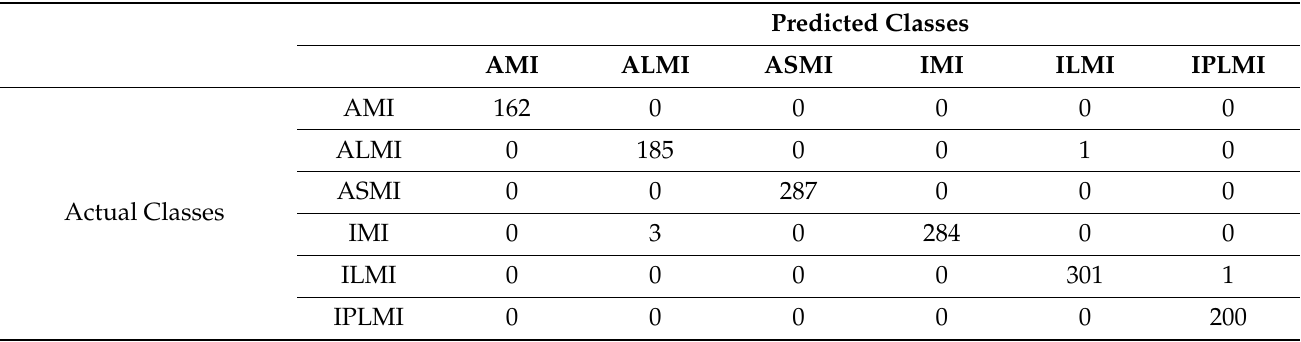
Figure 6. Plots of accuracy vs. epochs of multi-channel multi-scale deep CNN obtained using training and validation VCG instances for MI localization. Table 6. Confusion matrix obtained using the proposed second stage multi-channel multi-scale deep CNN classifier for MI